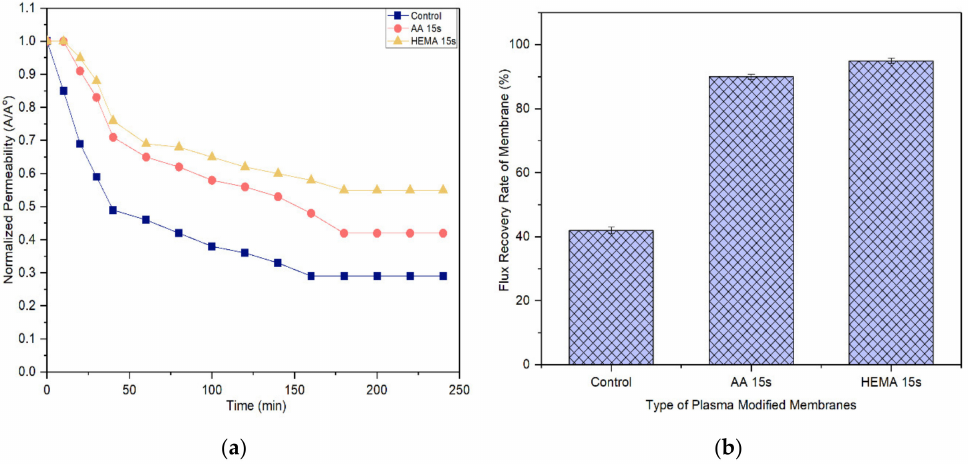
Figure 11. ( a ) Flux decline curves of membranes using 2000 mg / L BSA solution and ( b ) flux recovery rate (FRR) of membranes after water cleaning. Error bars indicate standard deviations.